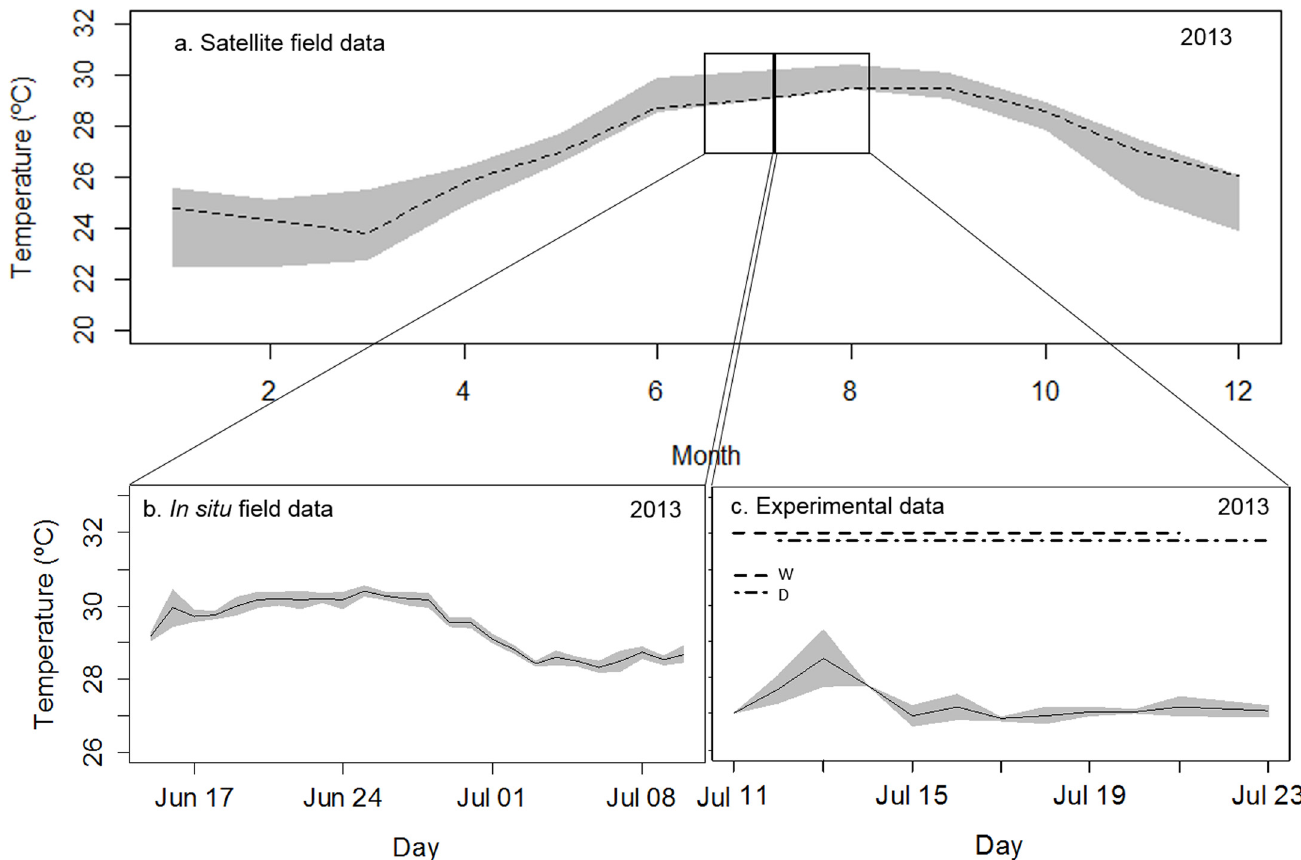
Fig 3. Thermal history of the corals tested in a series of laboratory-based transmission experiments. a . Mean monthly sea-surface temperature (dotted line) and the minimum and maximum of the 10-year monthly mean (gray range) obtained from HadI sea-surface temperature records for the site of collection [44]. b . Mean daily sea-surface temperature from a Hobo 1 data logger deployed near the site of collection (data logged every 15 minutes) and the standard deviation around the mean (gray range). c . Mean daily experimental temperatures measured with a standard laboratory thermometer for the duration of the transmission experiments. Gray range = standard deviation around the mean; W = waterborne transmission, D = direct-contact transmission.